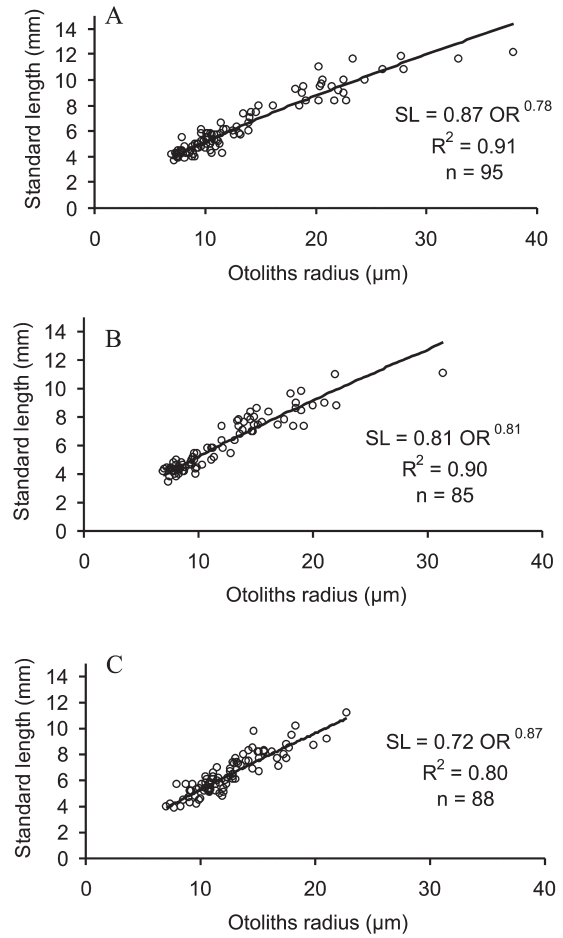
Fig . 5. – Allometric relationships between the maximum otolith ra- dius and standard length of anchovy larvae. A) summer, B) autumn, C)